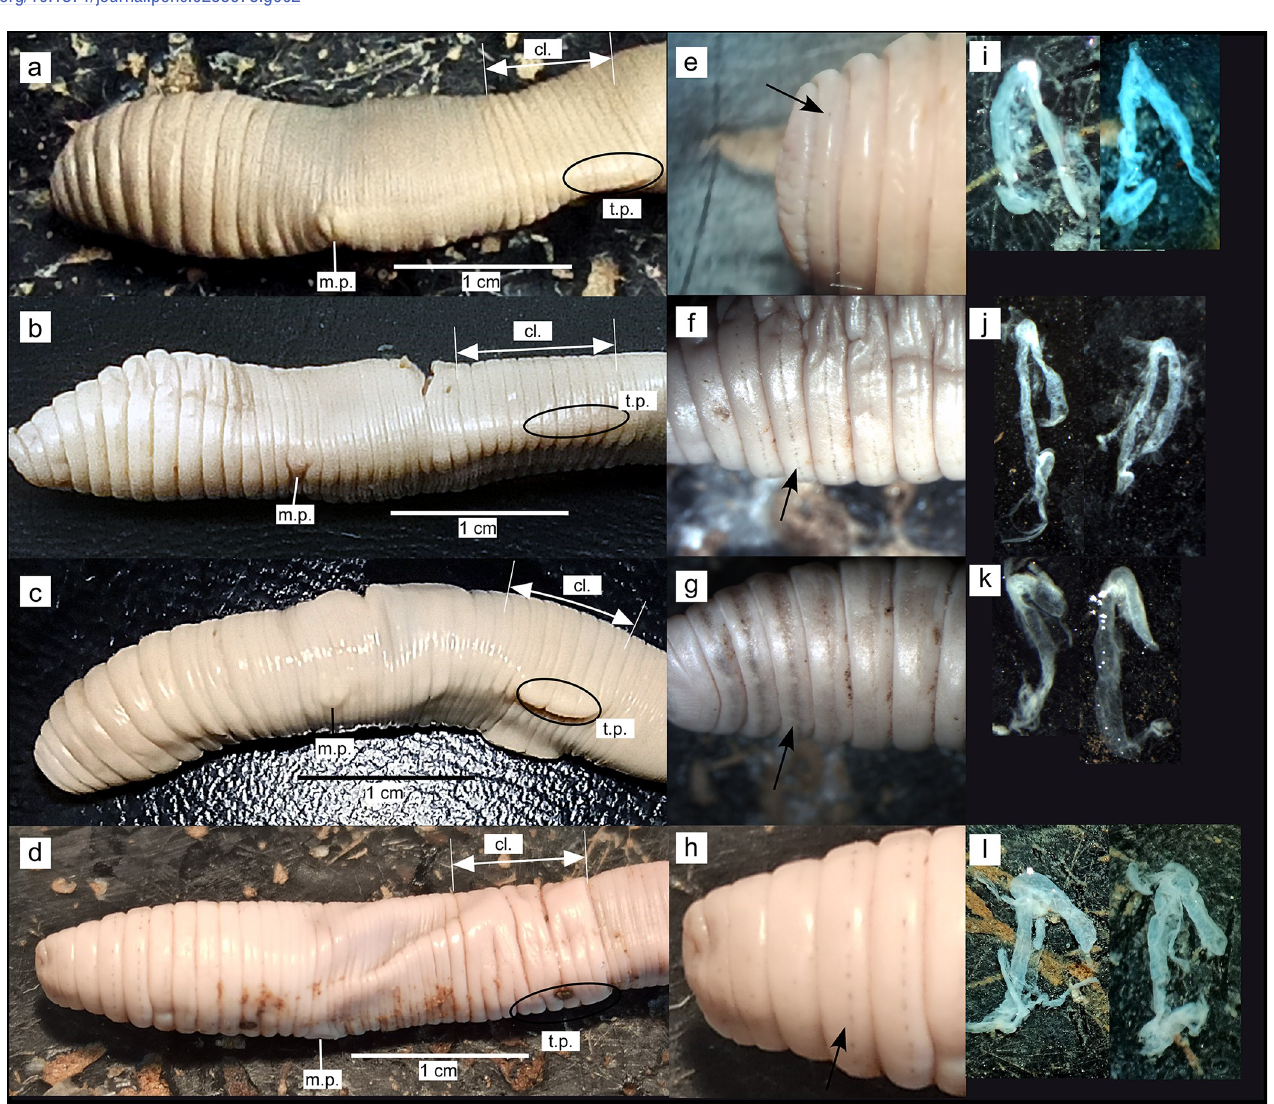
Fig 3. External and internal morphology of fixed specimens of Gatesona chaetophora (a, e, i ) Gatesona rutena (b, f, j) Gatesona lablacherensis (c, g, k) and Gatesona serninensis (d, h, l). The insets show a detailed view of the pigmentary dots characteristic of Gatesona species (e, f, g, h), and their nephridial bladders (i, j, k, l). Abbreviations: cl. = clitellum, m. p. = male pore, t. p. = tubercula pubertatis. https://doi.org/10.1371/journal.pone.0255978.g003 PLOS ONE | https://doi.org/10.1371/journal.pone.0255978 September 2,